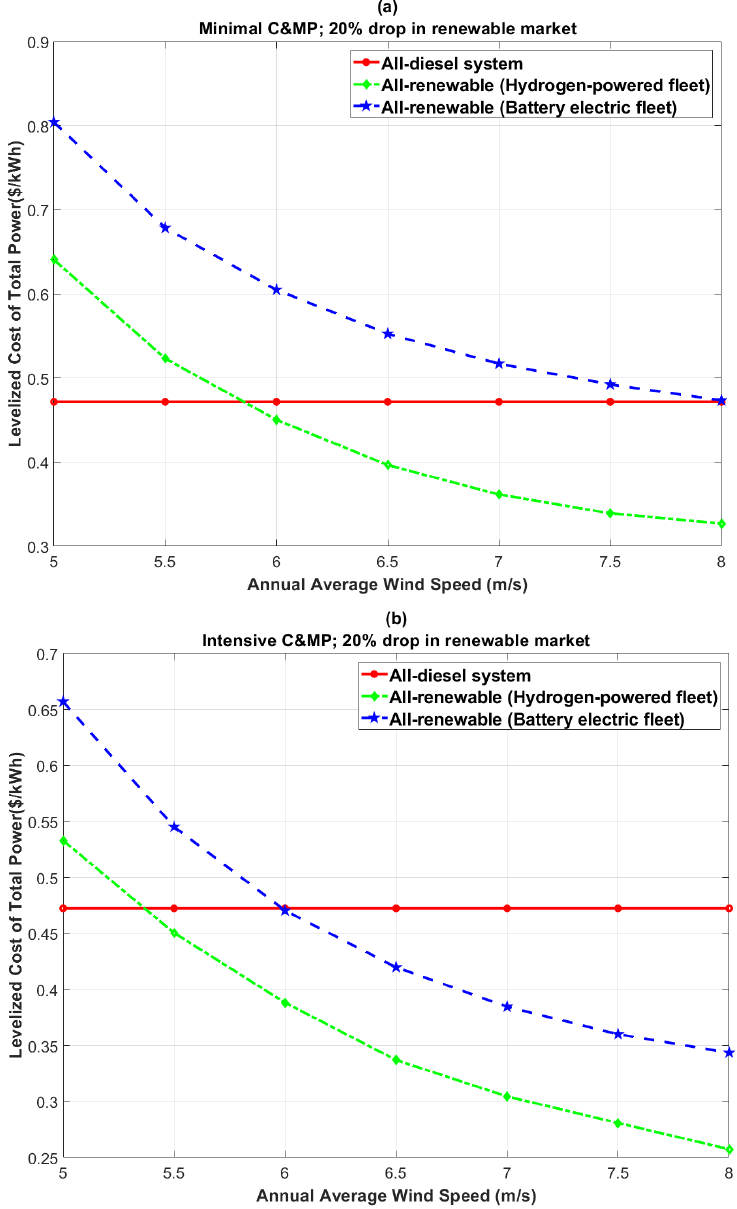
Figure 12. Wind speed impact on all-renewable system (Battery and FC storage config.) with 20% drop in renewable market: ( a ) surface mine with minimal C&MP; ( b ) surface mine with intensive C&MP.